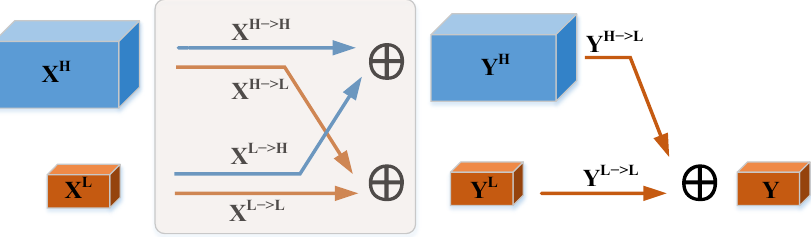
Figure 3. 3D OctConv Module.